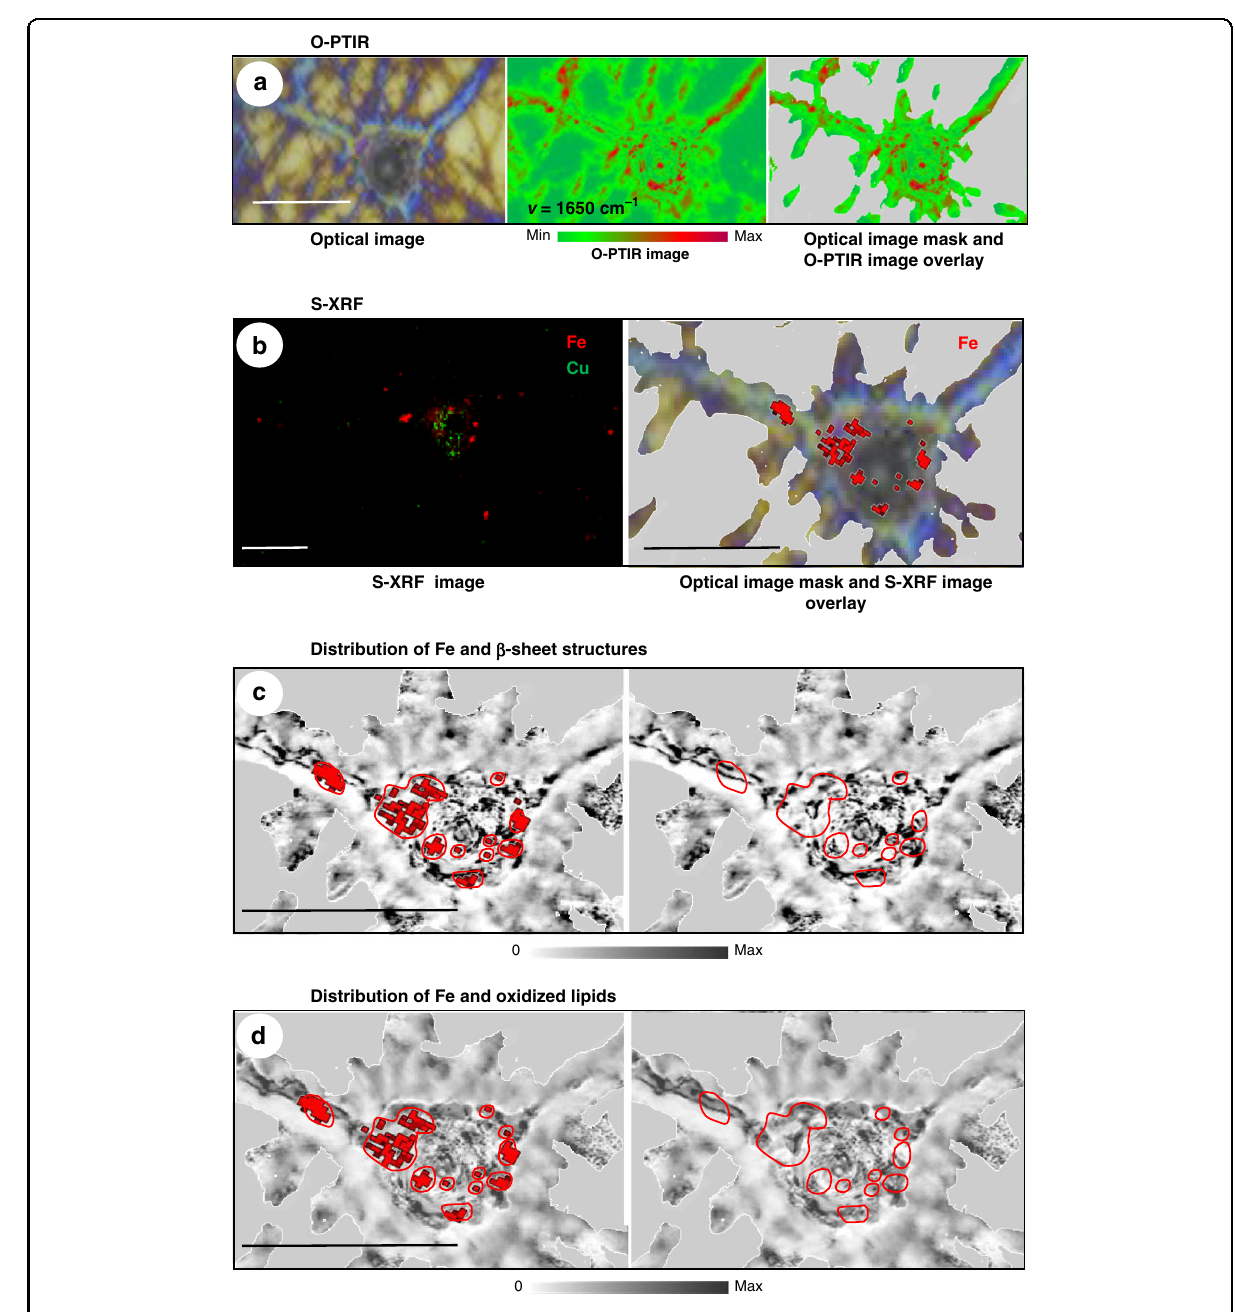
Fig. 4 Correlative super-resolution optical photothermal infrared and scanning X-ray fl uorescence imaging of individual neuron. a Left panel: Bright- fi eld image of APP-KO primary neuron incubated with 5 × 10 − 7 M synthetic A β (1 – 42). Middle panel: O-PTIR maps acquired at frequencies 1650 cm − 1 . Color bar shows the intensity of photothermal amplitude. Right panel: overlay of a bright- fi eld image with the mask created by an intensity threshold. b Left panel: Elemental distribution of Fe and Cu in the same neuron shown in ( a ). Right panel: overlay of Fe map with the masked visual image. c Left panel: Overlay of Fe map with the O-PTIR ratio map derived from the image acquired at 1628 cm − 1 and divided by the image acquired at 1650 cm – 1 . Fe clusters are encircled. Distribution of β -sheet structures, encircled area indicate overlap with Fe. Red circles indicate overlap of Fe clusters and elevations in the β -sheet structural content. d Left panel: a ratio map was derived from the image of the same neuron shown in ( a , b ) acquired at 1740 cm − 1 and divided by the image acquired at 1650 cm − 1 . Right panel: overlay oxidized lipid map with the mask. Red circles indicate overlap of Fe and overlay oxidized lipids. Scale bars are 20